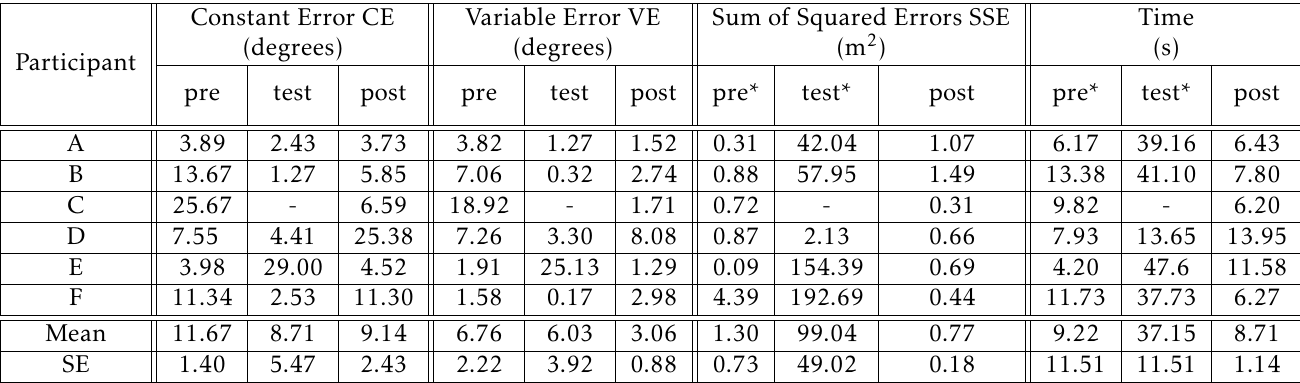
Table 3. Constant error (means of deviation angles), Variable error (standard error of deviation angles), Sum of Squared Errors (SSE) and Time results for pre-, test and post-test